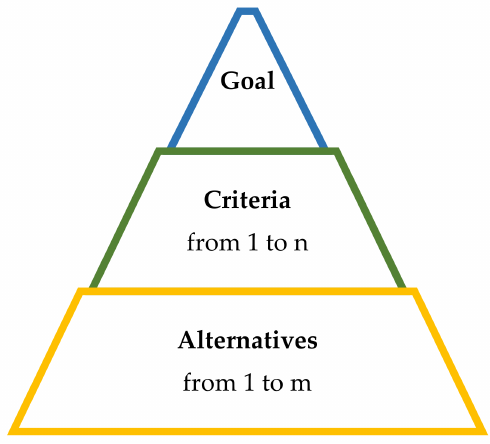
Figure 1. General structure of the hierarchy